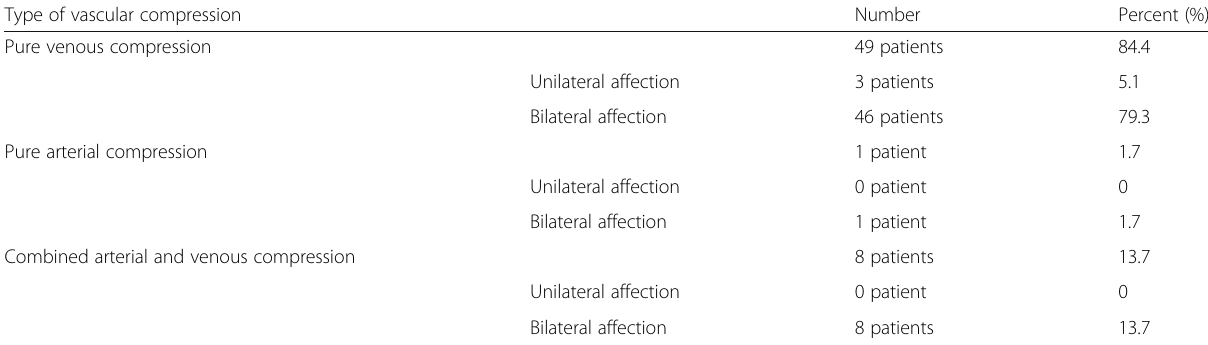
Table 1 Demonstrating the type of vascular compression at the thoracic outlet as well as the side of affection, and the number and the percent of cases